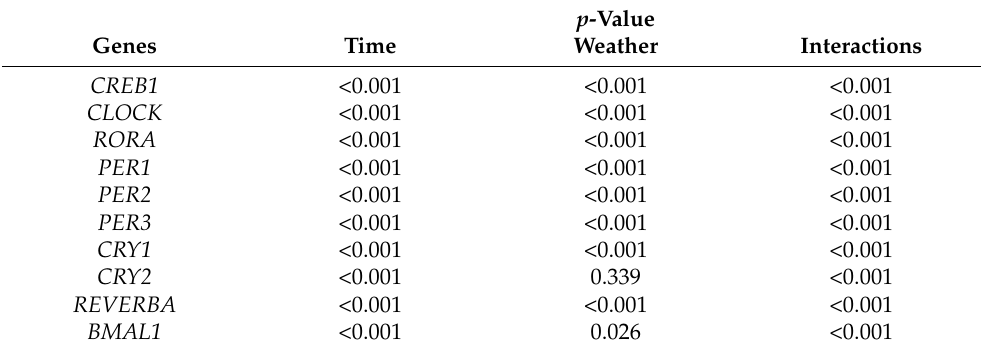
Table 4. Effects of light intensity and duration on the rhythm genes of mackerel tuna under different weather conditions.